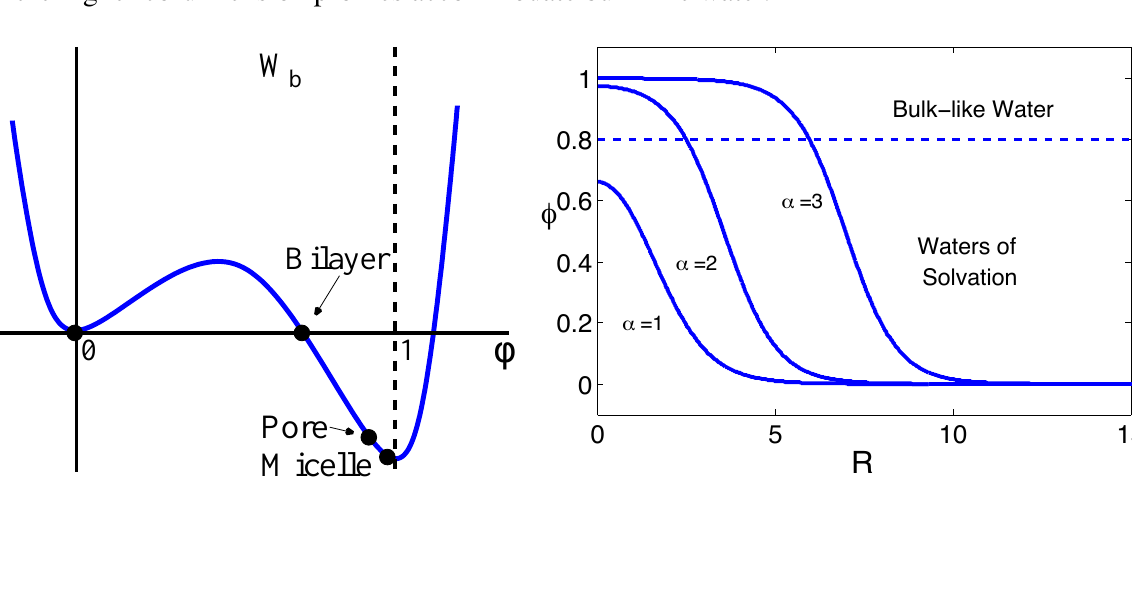
, for τ = 0 . 4 . The maximum value of solvent b − ; (Right) Half-profiles of φ for bilayers ( α = 1 , b α 0 . 4 . Only −